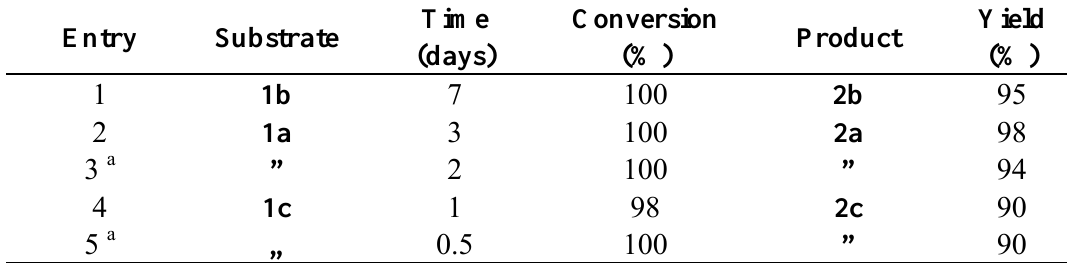
Table 3: Hydrogenation of halonitrobenzenes under 20 bar of H of Rh-pol (substrate: 2.12 mmol; solvent: EtOH 7 mL; substrate/Rh = 160